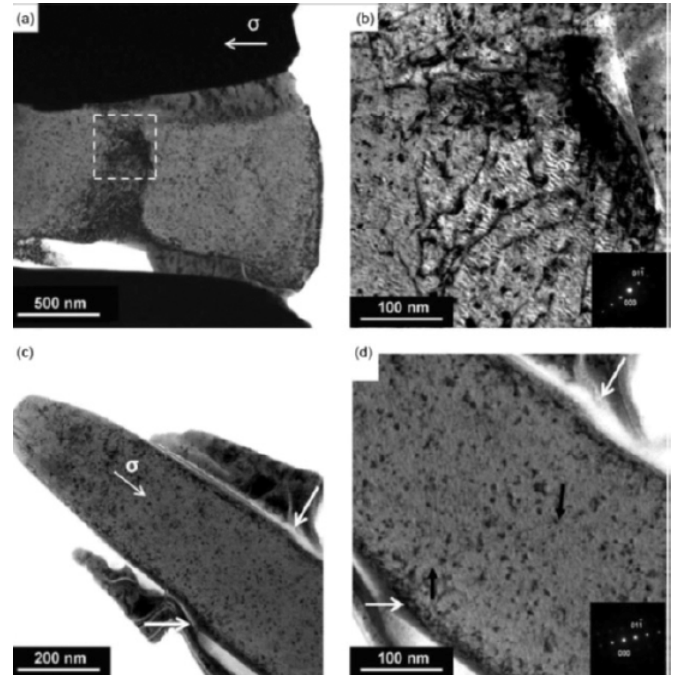
Fig. 29. Postmortem bright-field STEM images of the Fe pillars after compression tests. (a) 1000 nm; (b) magnified image of the area framed in (a); (c) 200 nm; (d) magnified image of the area indicated by the two white arrows in (c). The dislocation line marked by the black arrows. Reprinted with permission from Huang R, Li QJ, Wang ZJ, Huang L, Li J, et al. 2015. Flow Stress in Submicron BCC Iron Single Crystals: Sample- size-dependent Strain-rate Sensitivity and Rate-dependent Size Strengthening. Materials Research Letters 3, [238]: Copyright © 2015 Informa UK Limited.